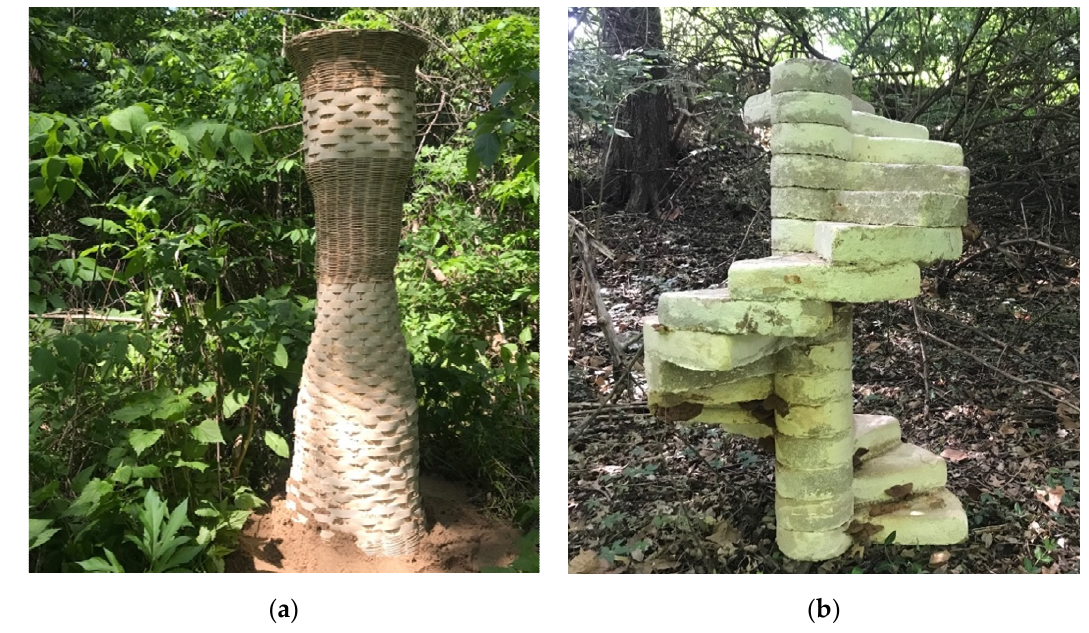
Figure 4. Monolithic and myco-welded structures grown by the author and students at Kansas State University in spring 2021, shown in their final installation sites. The structures were both larger than the available resources for actively drying the structures to stop growth, resulting in the emergence of fruiting bodies on the structures. ( a ) Two-meter-tall woven monolithic mycelium column; ( b ) half-scale myco-welded staircase with visible fruiting bodies that resulted from the two-stage growing process inherent to the myco-fabrication technique. Photos by the author.